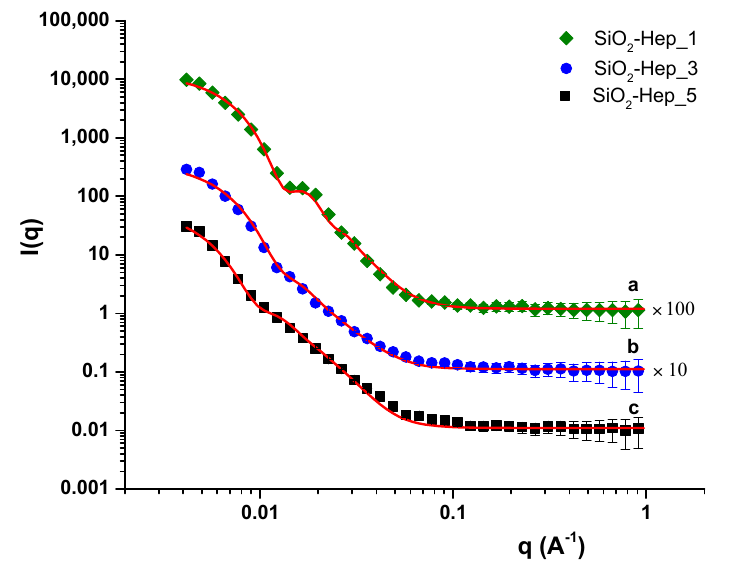
Figure 5. SANS profiles and corresponding best fitting curves of SiO 2 –Hep_1 ( a ), SiO 2 –Hep_3; ( b ) and SiO 2 –Hep_5; ( c ) suspensions in D 2 O.